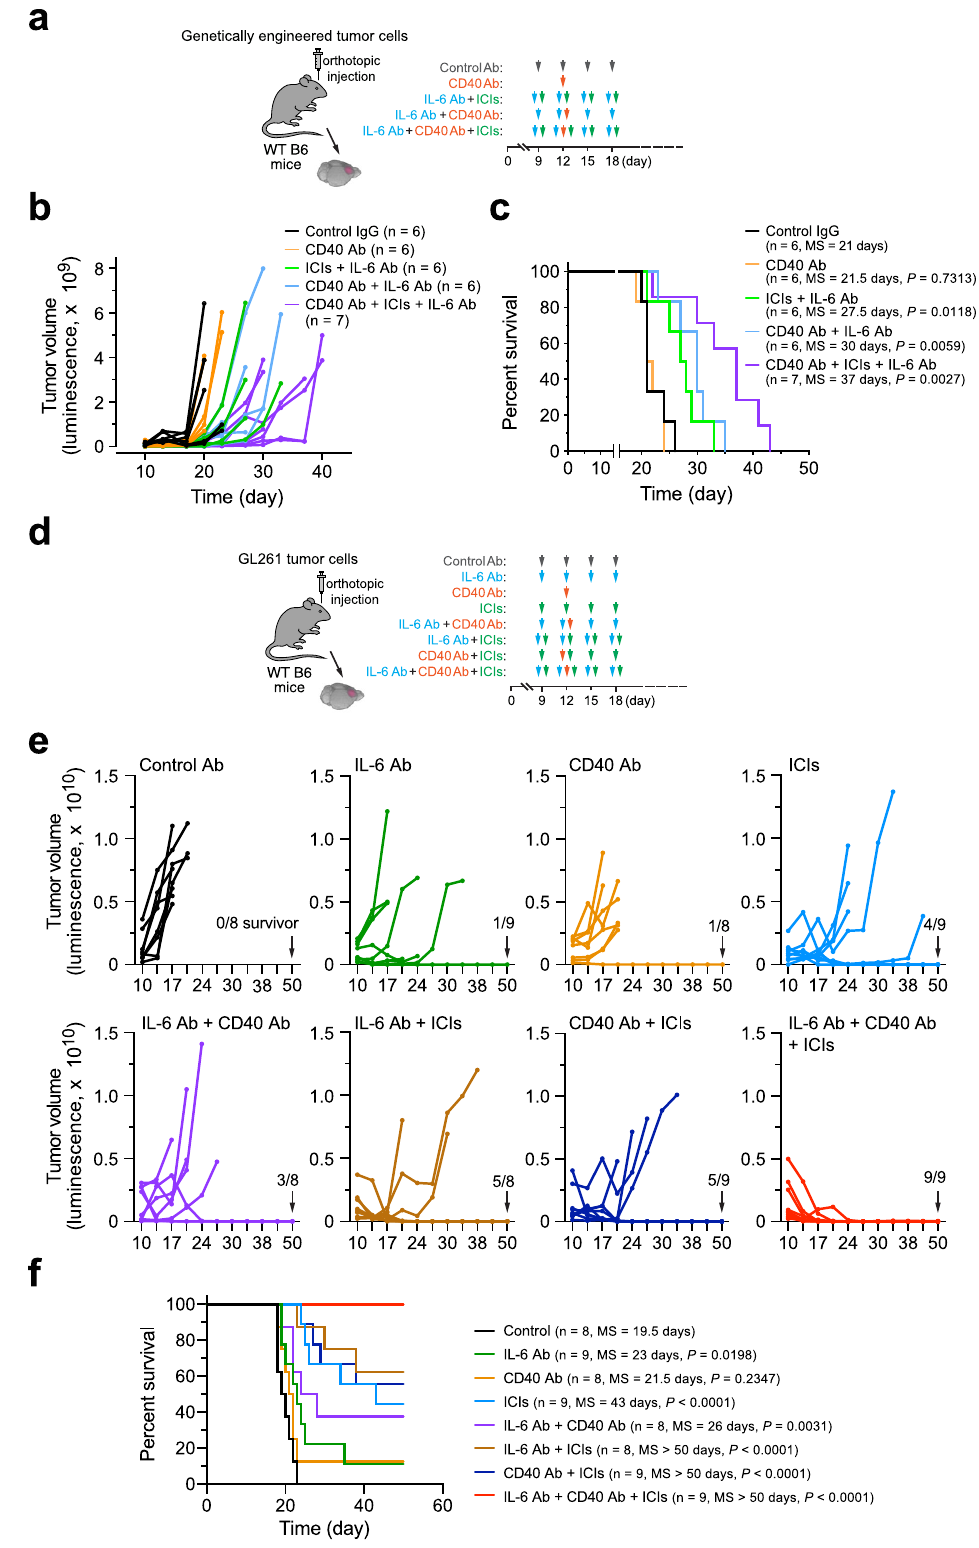
Fig. 5 IL-6 neutralization and CD40 stimulation sensitizes GBM to immune checkpoint blockade treatment. GBM was induced in mice by transplantation with a – c , tumor cells derived from RCAS-genetically engineered model ( n = 6 – 7 mice, speci fi c n numbers are shown in the fi gure) or d – f GL261 tumor cells ( n = 8 – 9 mice, speci fi c n numbers are shown in the fi gure), followed by different treatment and survival analyses. a , d Experimental procedure. b , e Tumor volume was analyzed by bioluminescence imaging. c , f Mouse survival was monitored and analyzed by two-sided Log-rank Mantel – Cox analysis. MS, median survival. Source data are provided as a Source data fi